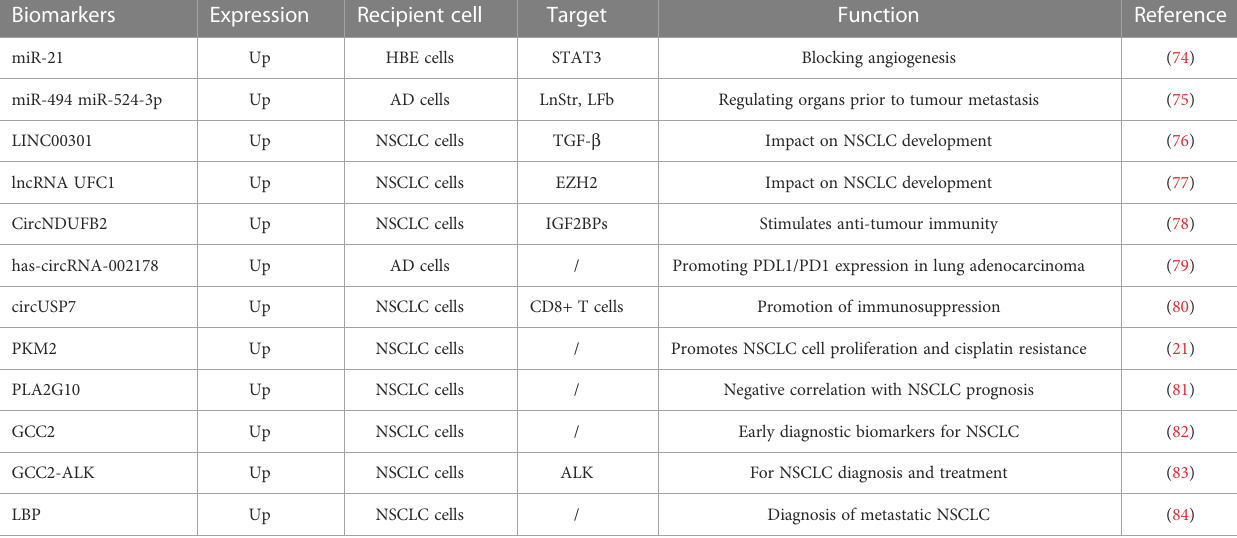
TABLE 3 Different components of EV as biomarker in NSCLC immunotherapy